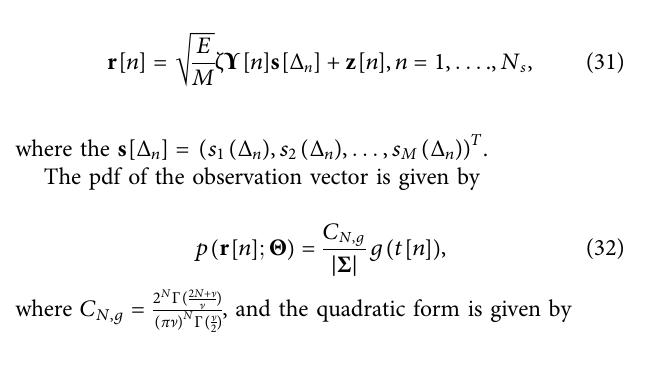
Frontiers in Signal Processing |